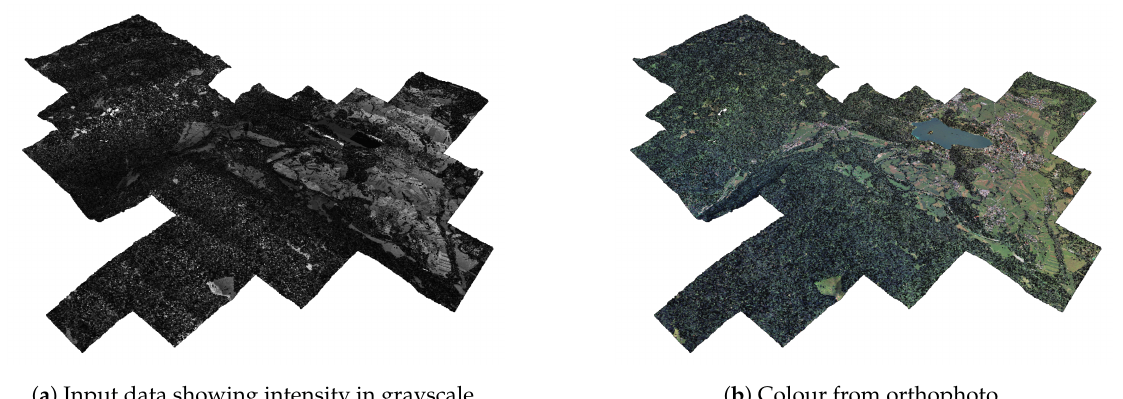
Figure 12. The point-cloud data without colour ( a ) and with colour information ( b